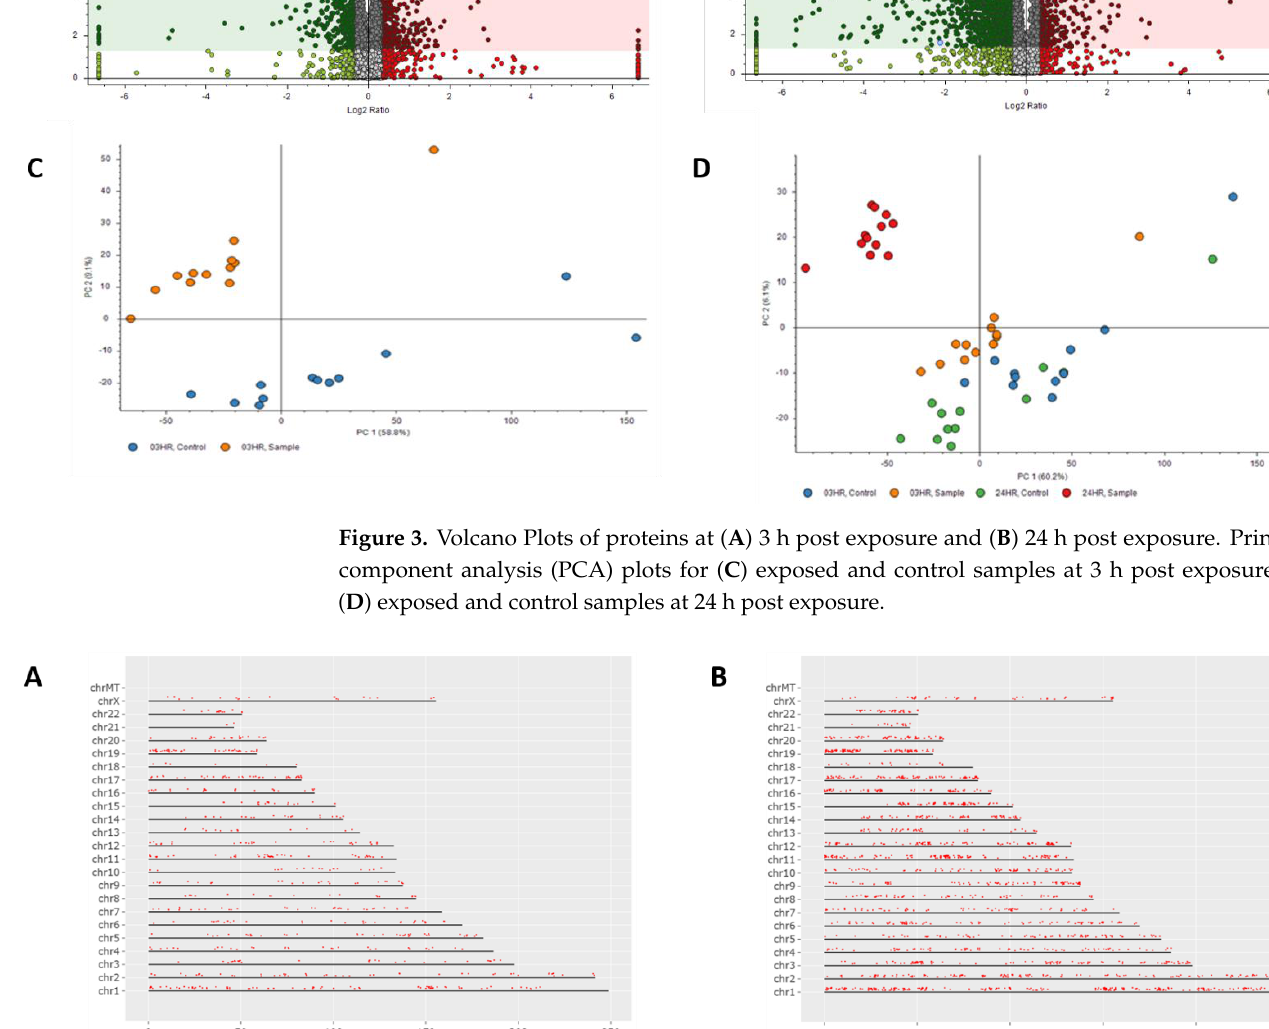
Figure 5. Bar graphs of the grouped abundances of ( A ) plasminogen activator inhibitor 2 (PAI2) expression profile across the control groups and the 3 h and 24 h exposures, ( B ) Urokinase plasmin- ogen activator surface receptor dysregulation at the 3 h and 24 h marks indicating an upregulation